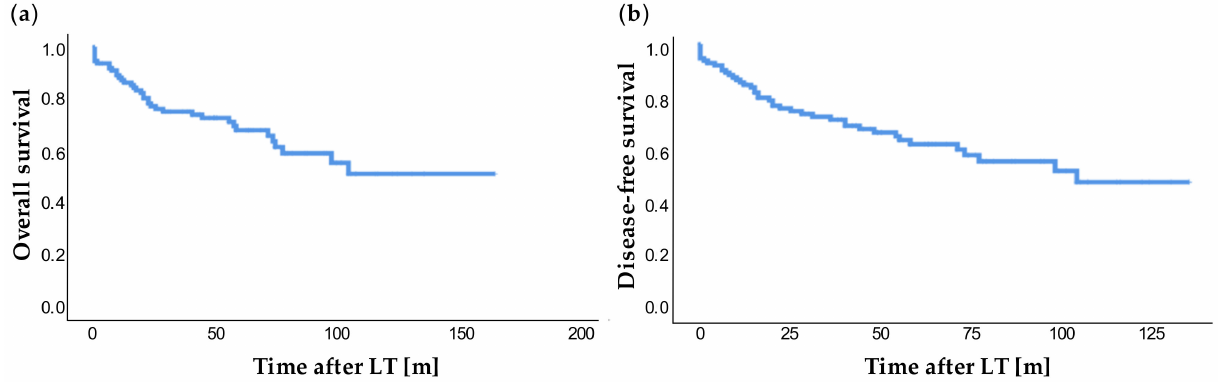
Figure 2. Overall survival ( a ) and disease-free survival ( b ) after LT. Time in years